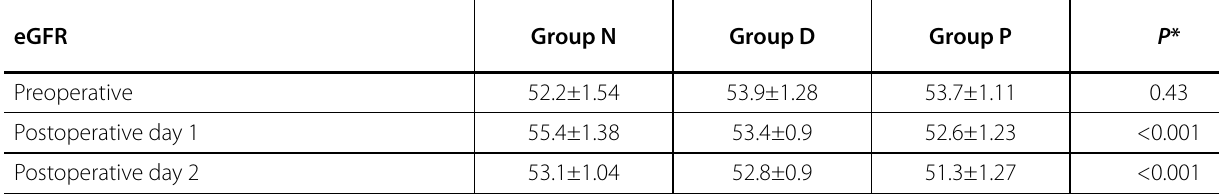
Table 3. Evaluation of eGFR with ANOVA.